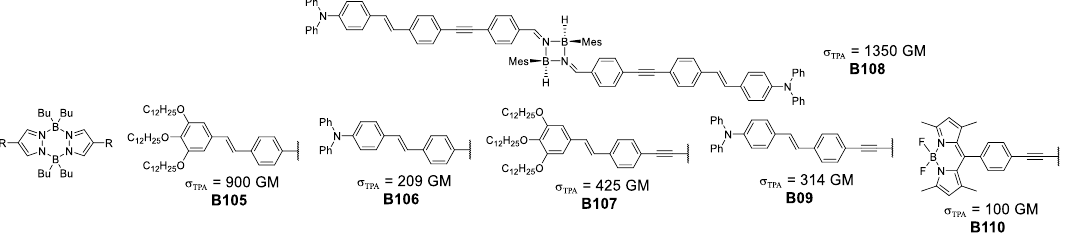
Figure 33. Cyclodiborazane and pyrazabole species developed for their TPA responsiveness.